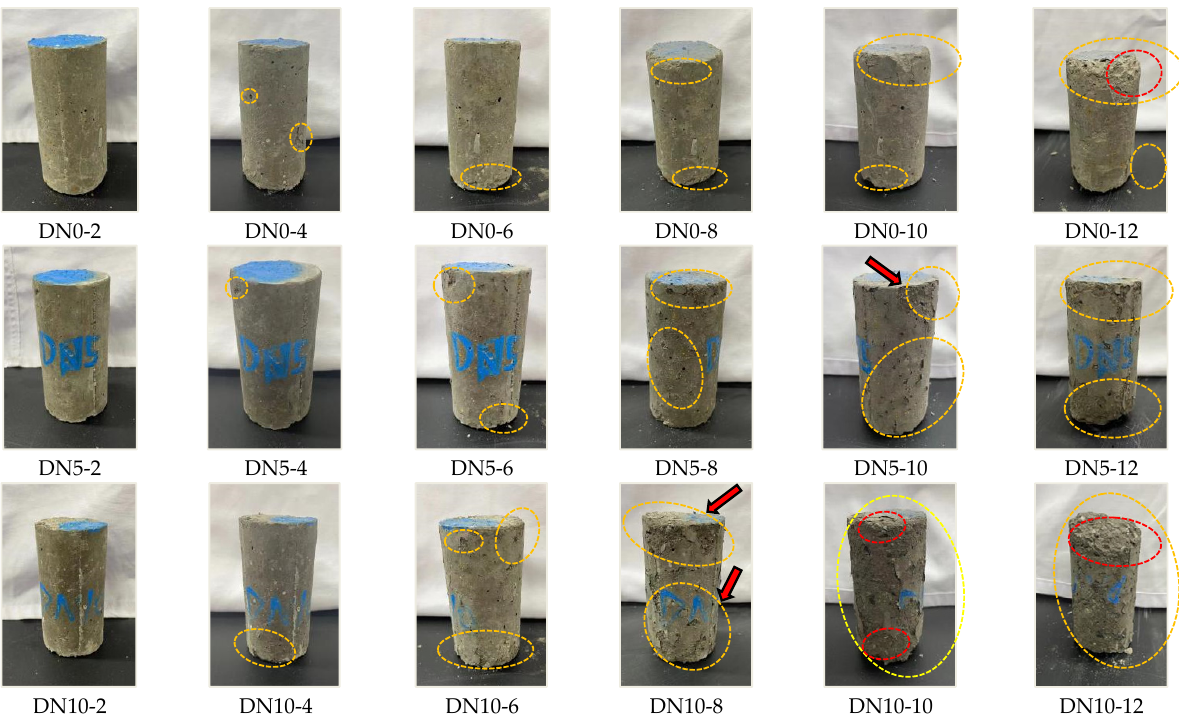
Figure 5. The appearance changes of different concentrations of sulphate during dry–wet